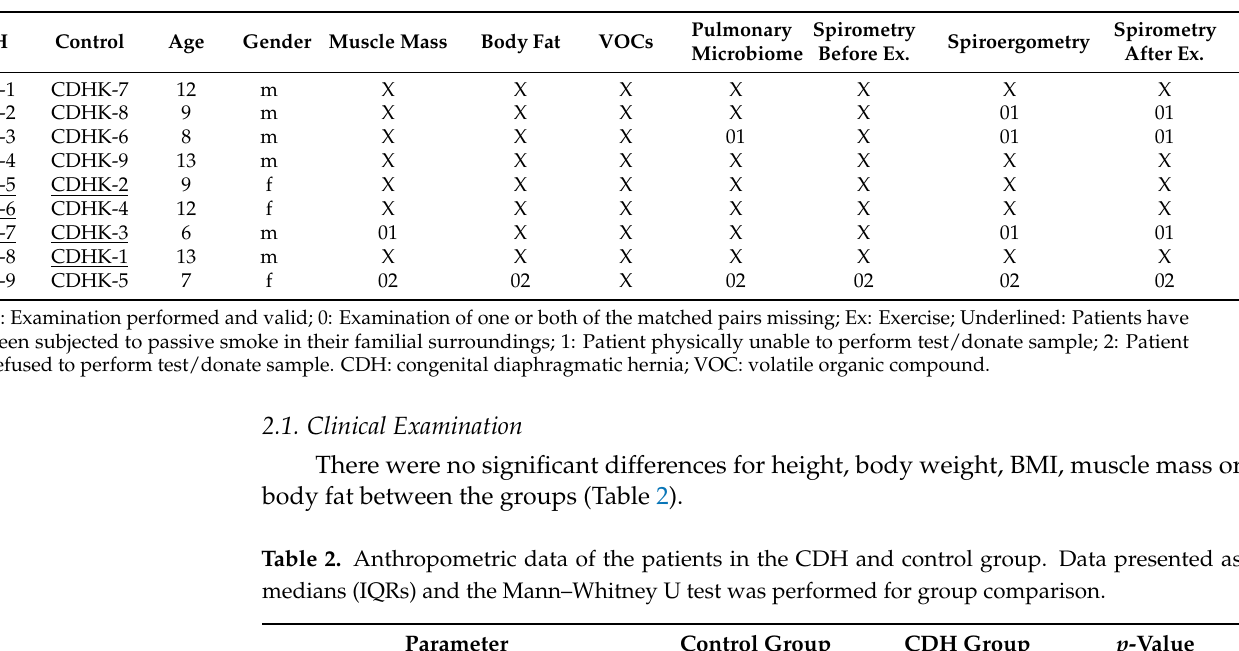
Table 1. Overview of CDH patients and their age and sex-matched healthy controls.